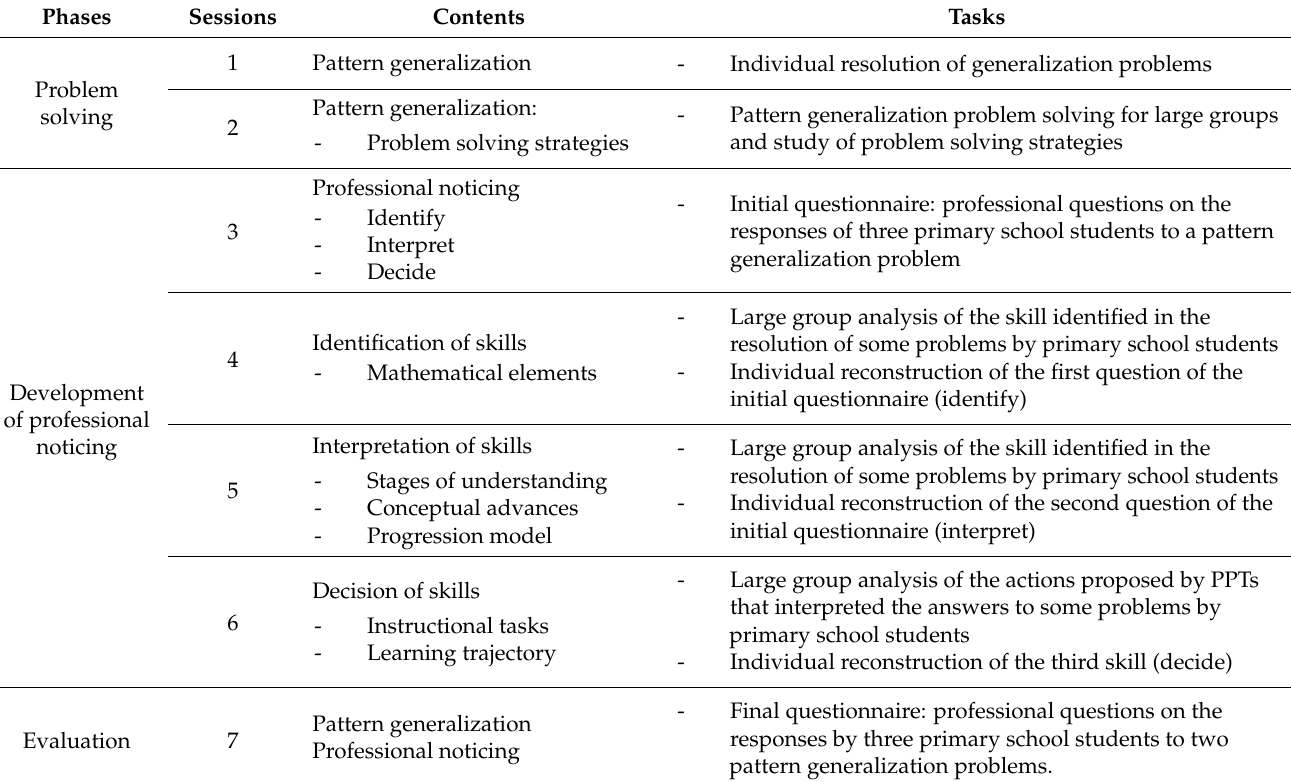
Table 2. Contents and tasks of the teaching module